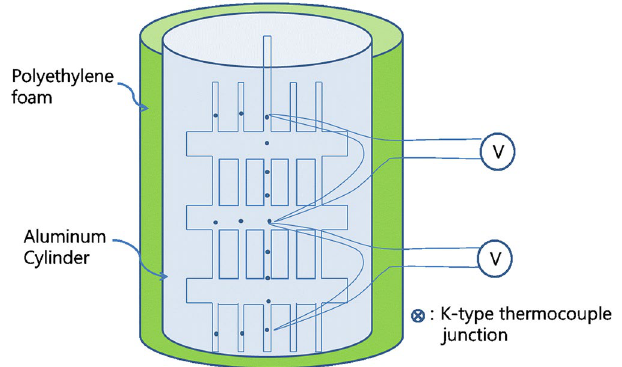
Figure 1. Schematic of the insulated air column to measure a temperature